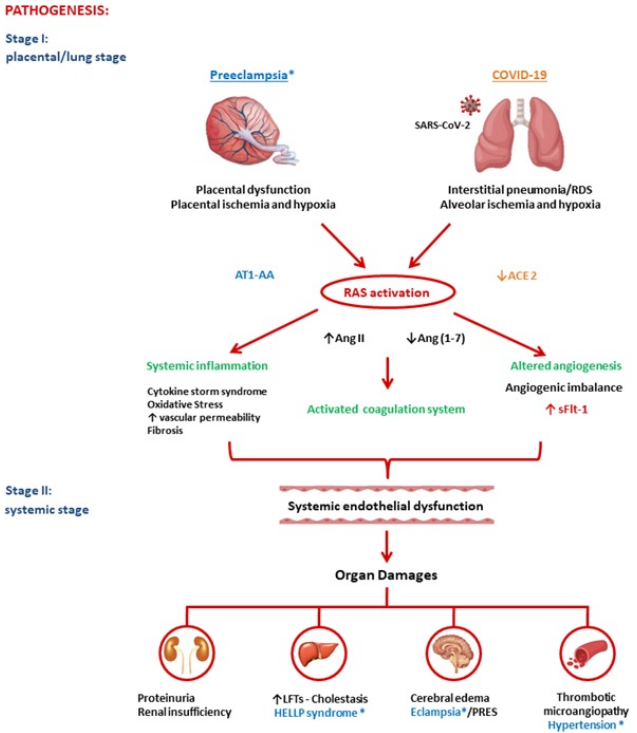
Figure 1. Schematic summary of the pathogenesis of preeclampsia and COVID-19 . Legend: AT1-AA: Angiotensin II Type 1 Receptor Agonistic Autoantibody ; ACE2: Ang-Converting Enzyme 2 ; RAS: Renin-Angiotensin System ; Ang II: Angiotensin II ; Ang 1–7: Angiotensin 1–7; sFlt-1: soluble FMS-like tyrosine kinase-1; LFTs: Liver Function Tests; HELLP Syndrome: Hemolysis, Elevated Liver enzymes, Low Platelets; PRES: Posterior Reversible Encephalopathy Syndrome .